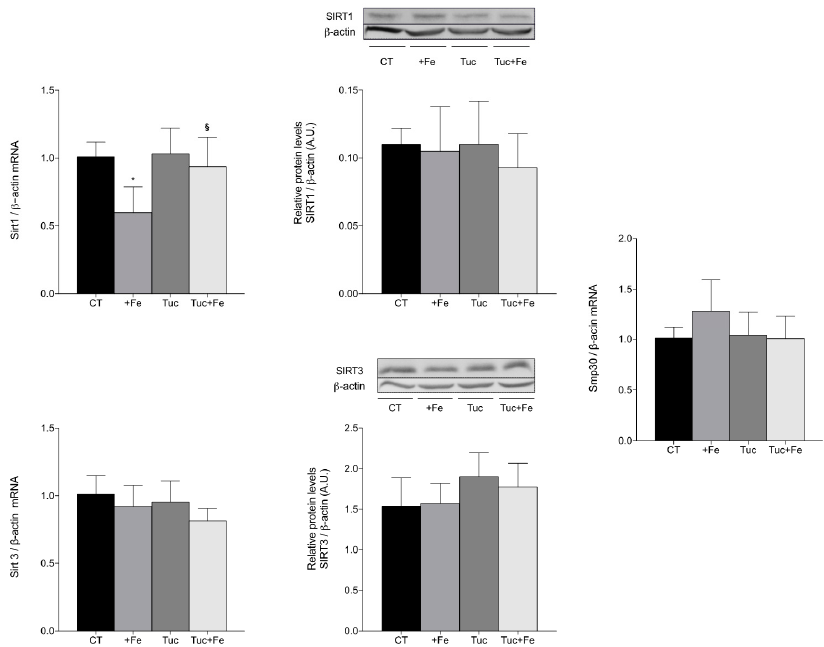
Figure 6. Renal mRNA quantification of Sirt1, Sirt3 and Smp30 and protein levels determination of SIRT1 and SIRT3 in kidney of adult rats treated for 12 weeks. Data correspond to average ± standard deviation ( n = 6 ). * Statistical differences compared to CT group ( p < 0.05). § Statistical difference compared to +Fe group ( p < 0.05).